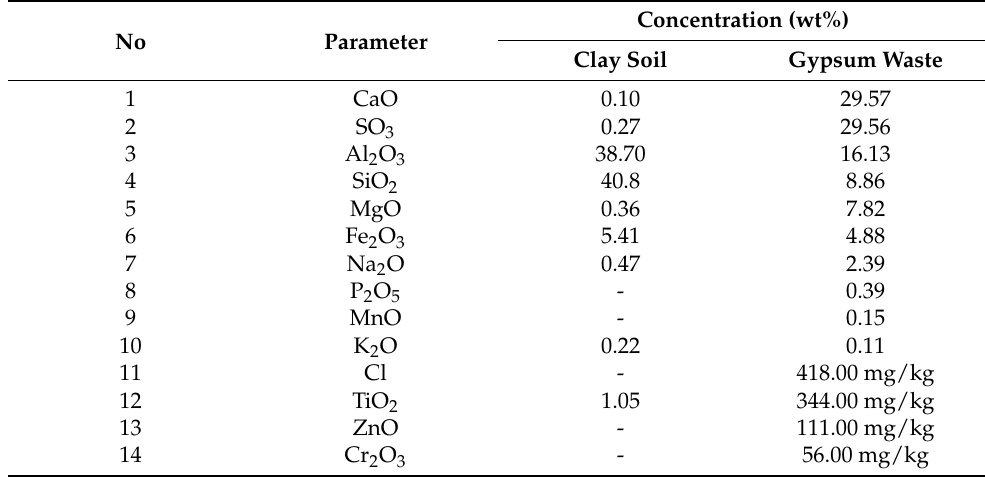
Table 2. XRF of clay soil and gypsum waste.